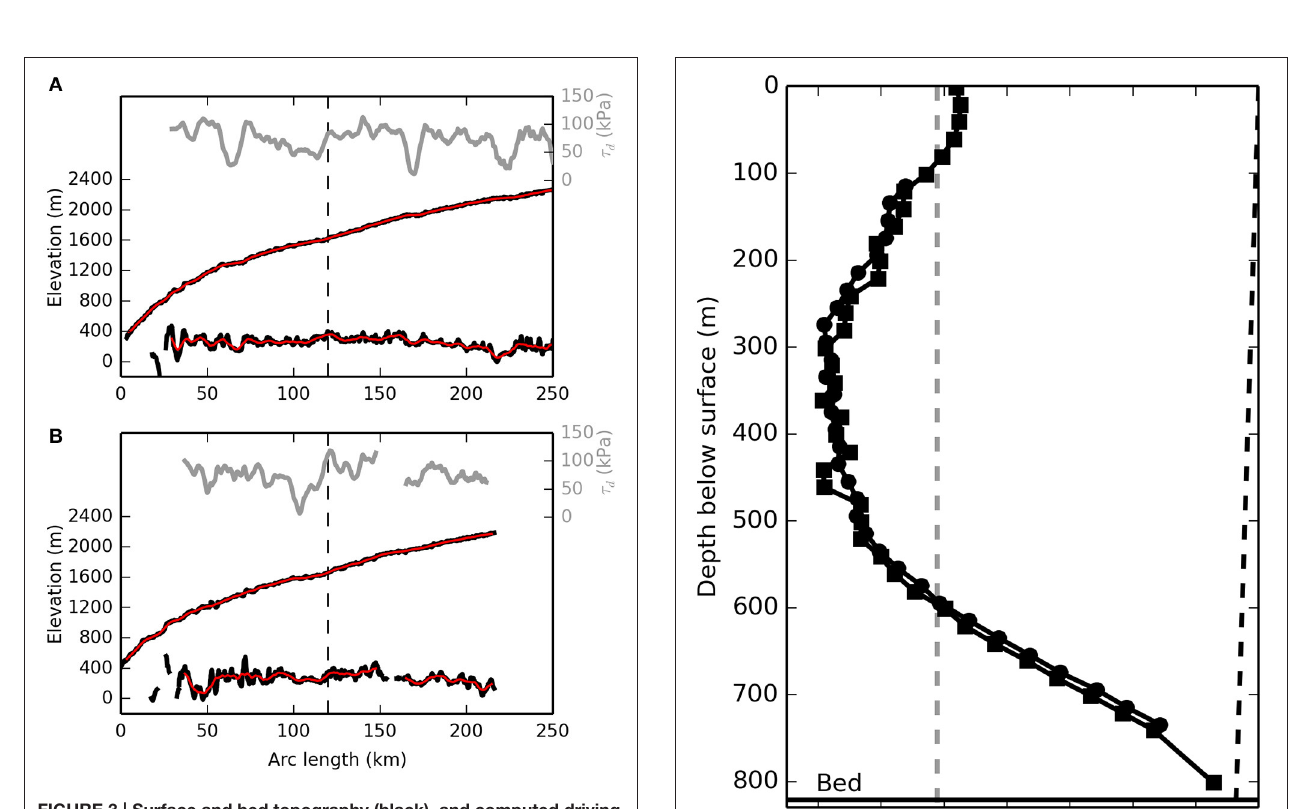
FIGURE 3 | Surface and bed topography (black), and computed driving stress (gray) along two IceBridge flightlines (A) and (B) (Allen et al., 2010) which extend through our study area. Red lines represent smoothed topographic profiles used to compute driving stresses. Dashed black line marks the approximate onset of the decline in driving stress referenced throughout the text. Locations of the flightlines are shown in Figure 2 .